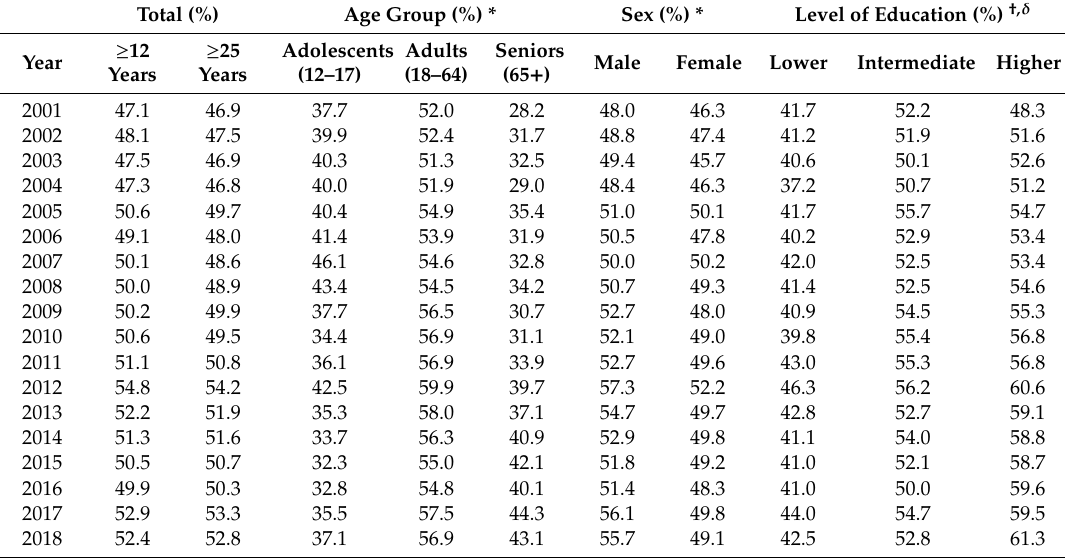
Table A3. Adherence levels to the first component of the Dutch physical activity guidelines consisting of 150 moderate and vigorous intense physical activity per week for adults, one hour per day for adolescents, in percentages, stratified by age groups, sex, and level of